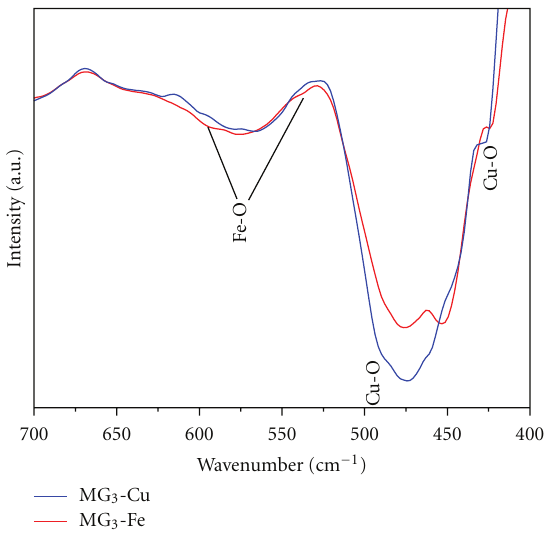
Figure 4: FT-IR spectra at 700–400 cm − 1 interval, for MG 3 -Cu doped and MG 3 -Fe doped.